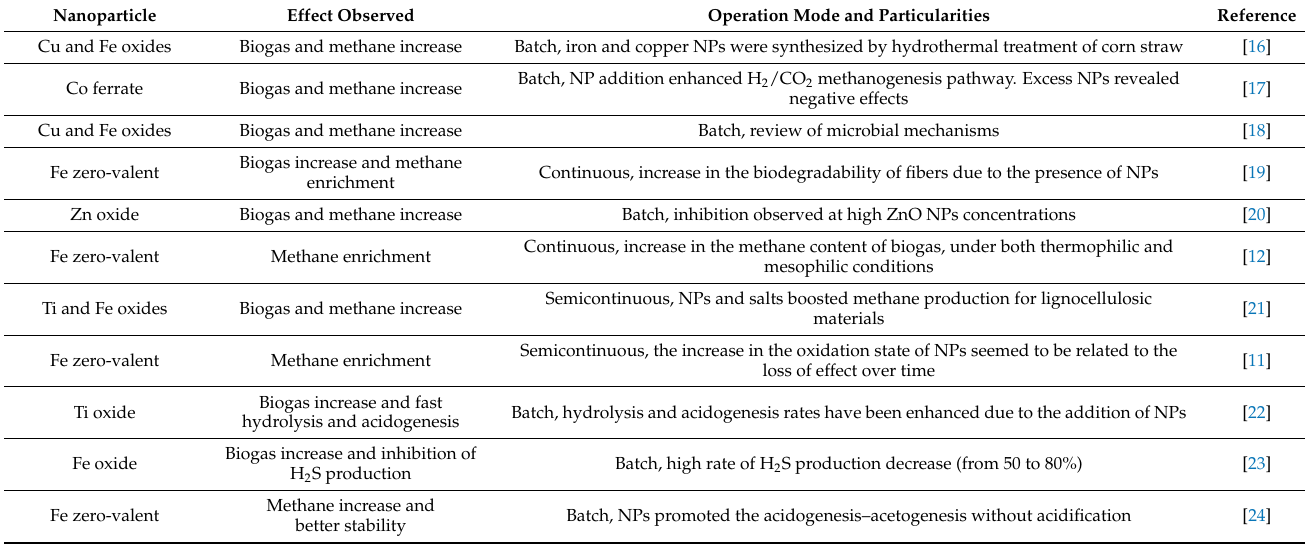
Table 1. Examples of studies using inorganic metallic nanoparticles and their effect on anaerobic digestion.